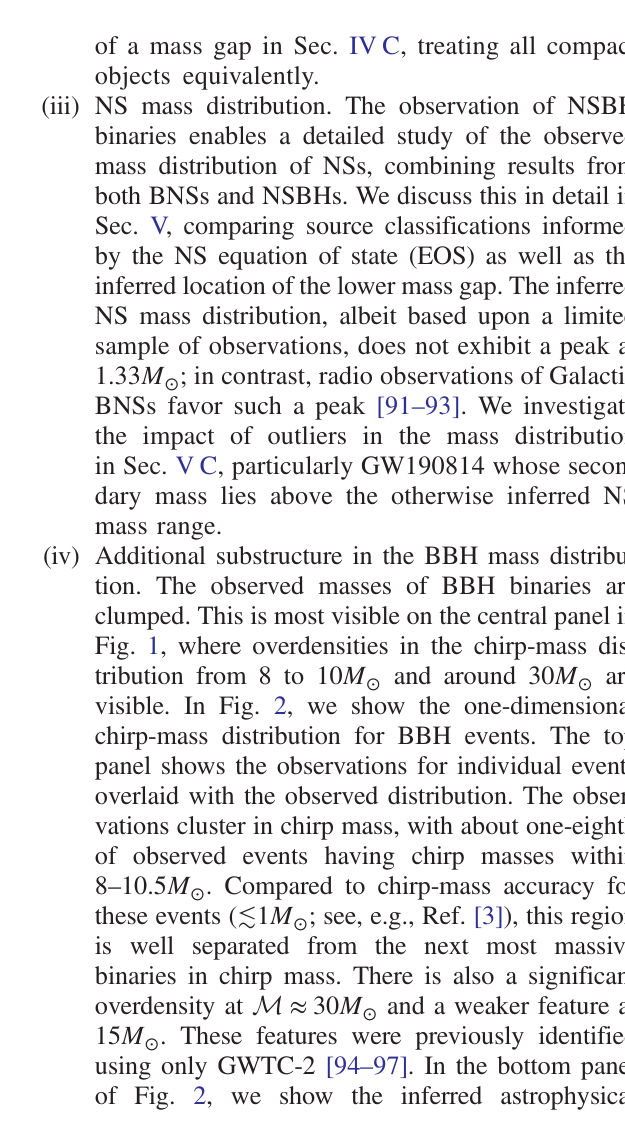
and chirp mass M , and eff